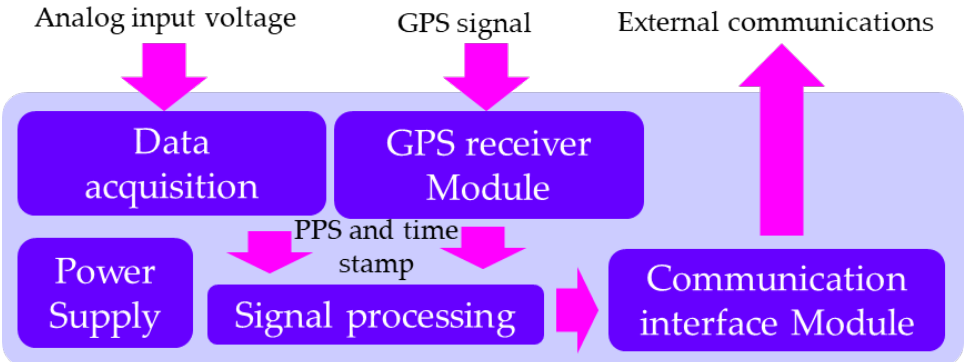
Figure 4. Conceptual block diagram showing the typical structure of a PMU, similar to the one developed in this scientific paper (see Figure 2).